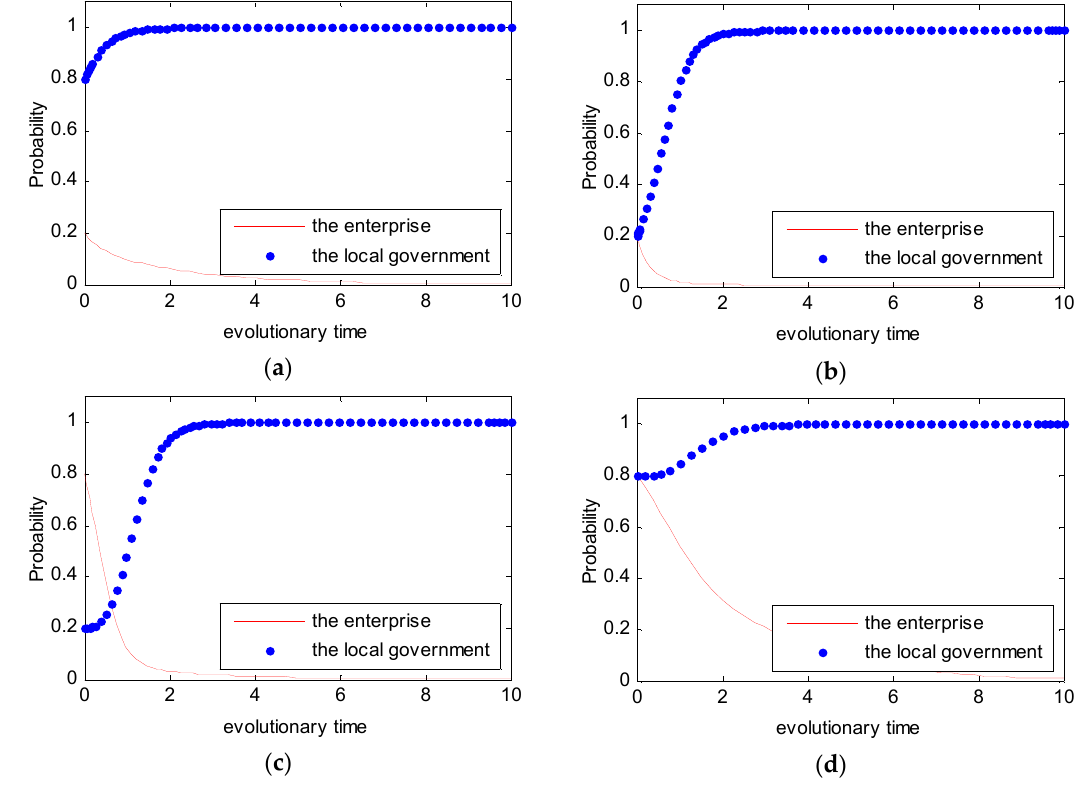
Figure 7. Probability of choosing a strong willingness strategy for different time t. ( a ) p t ( 0 ) = 0.2, q t ( 0 ) = 0.8; ( b ) p t ( 0 ) = 0.2, q t ( 0 ) = 0.2; ( c ) p t ( 0 ) = 0.8, q t ( 0 ) = 0.2; and ( d ) p t ( 0 ) = 0.8, q t ( 0 ) =